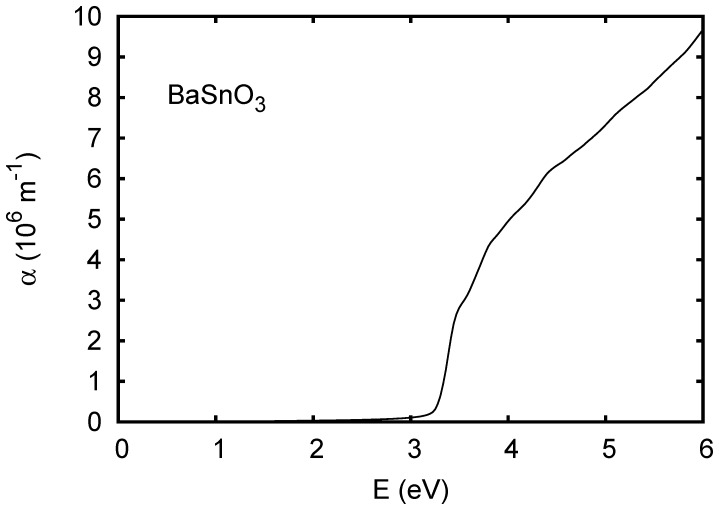
Calculated absorption spectrum of BaSnO3 using the TB-mBJ potential.A Lorentzian broadening of 0.025 eV was applied.